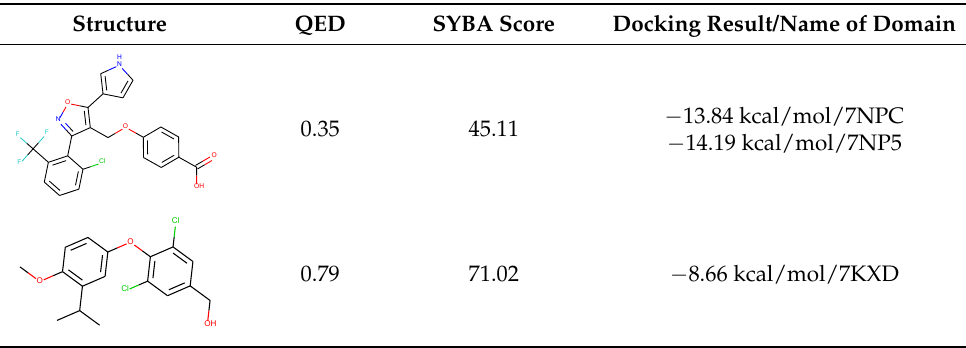
Table 4. Results of molecular docking for structures found in the Protein Database’s raw files [33,34], along with QED and SYBA scores—see SM Files S30 and S43–S46. Structure QED SYBA Score Docking Result/Name of